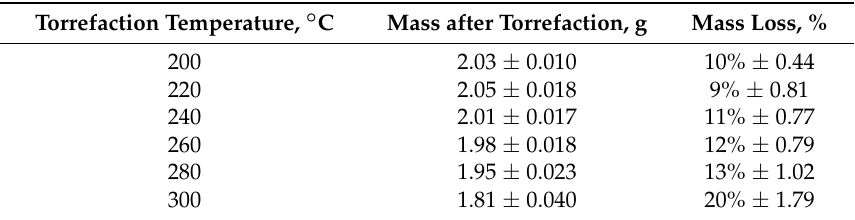
Table 2. Mass after sewage sludge torrefaction and percentage mass loss (Equation (8)) for six temperature profiles (200, 220, 240, 260, 280, 300 ◦ C).